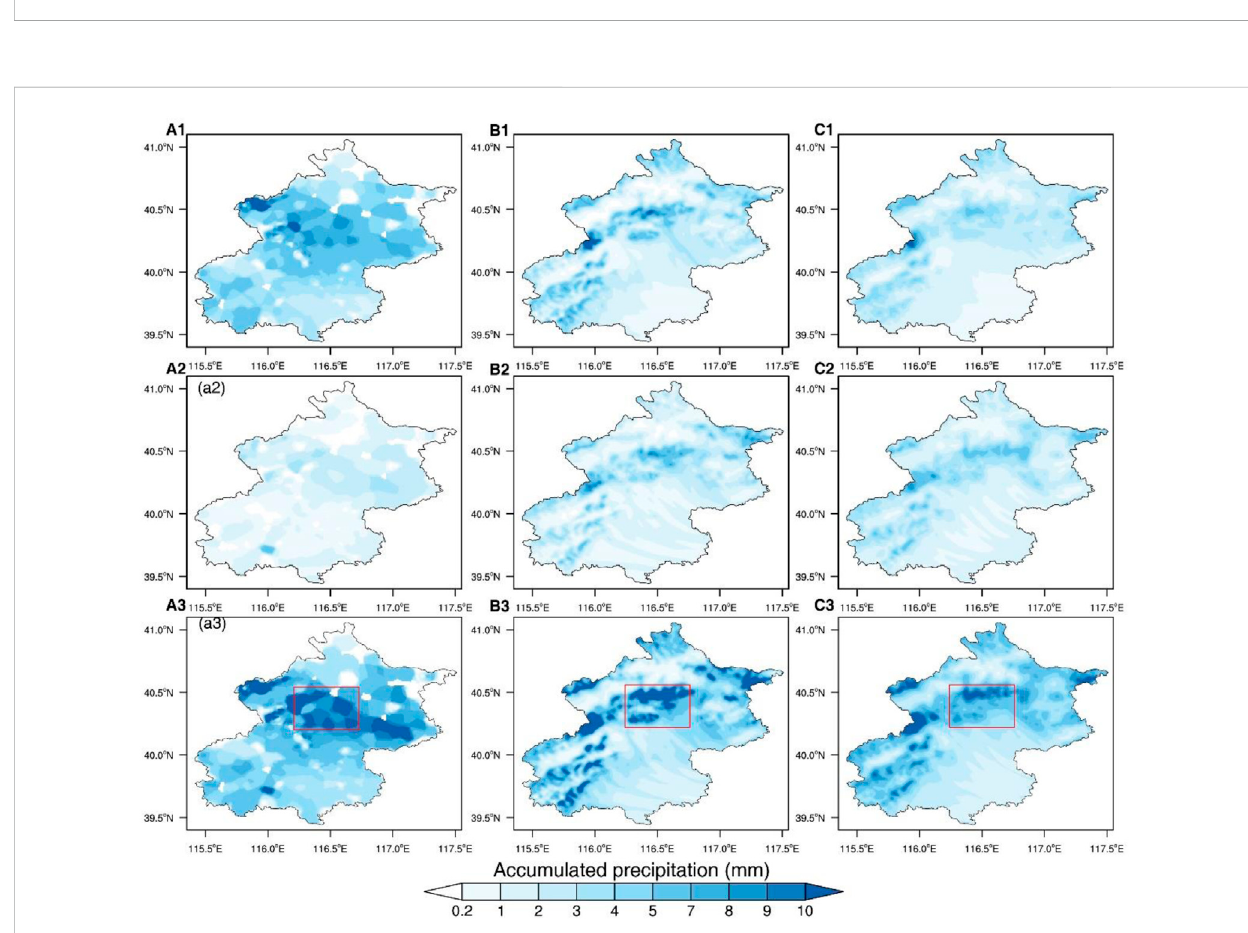
FIGURE 4 Accumulated 12-h and 24-h precipitation (unit: mm) of the (A1) – (A3) observations, (B1) – (B3) BULK scheme, and (C1) – (C3) BIN scheme in the Beijing area. Panels marked (A) arefor 1800 UTCon February 12 to0600UTC onFebruary13,2022, panels marked (B) arefor 0600UTC to1800 UTC on February13,2022,andpanelsmarked (C) arefor1800UTConFebruary12to1800UTConFebruary13,2022.Redrectangleindicatestheregionselected for later